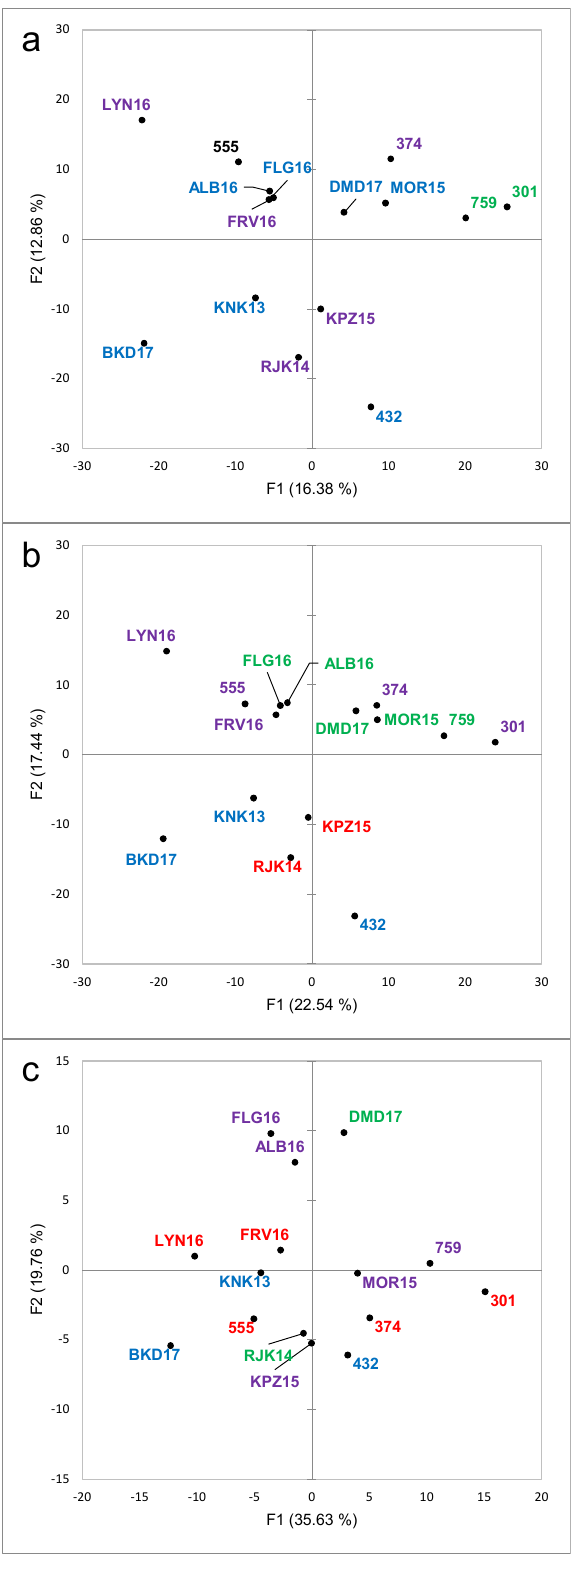
Figure 9. Principal Component Analysis score plot for Pinotage wines based on the results of the Liquid Chromatography-High Resolution Mass Spectrometry (LC-HRMS) analysis in positive and negative mode. Wine codes as indicated in the text. Groupings in the score plots are color-coded according to the Hierarchical Cluster Analysis on the same data. ( a ). Raw data; ( b ). First variable selection; ( c ). Second variable selection. Variable selection as described in the text.